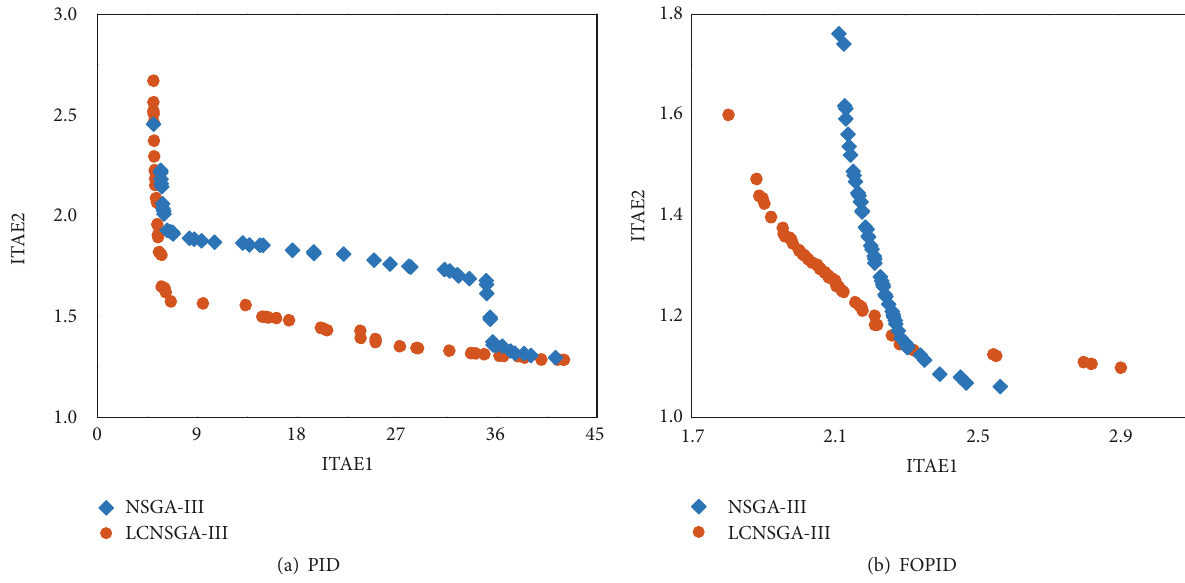
Figure 11: Comparison of Pareto fronts obtained by LCNSGA-III and NSGA-III for PID and FOPID controllers.